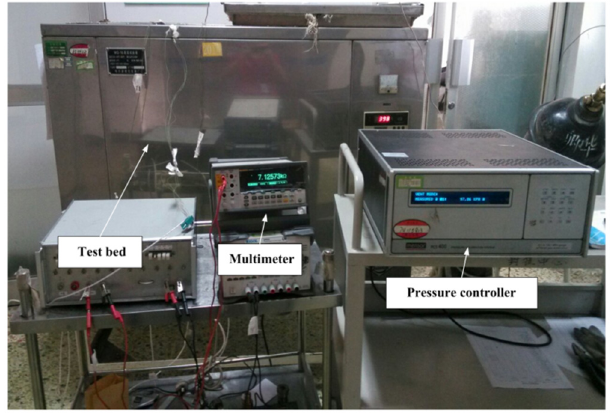
Figure 3. Image of the experimental set-up.